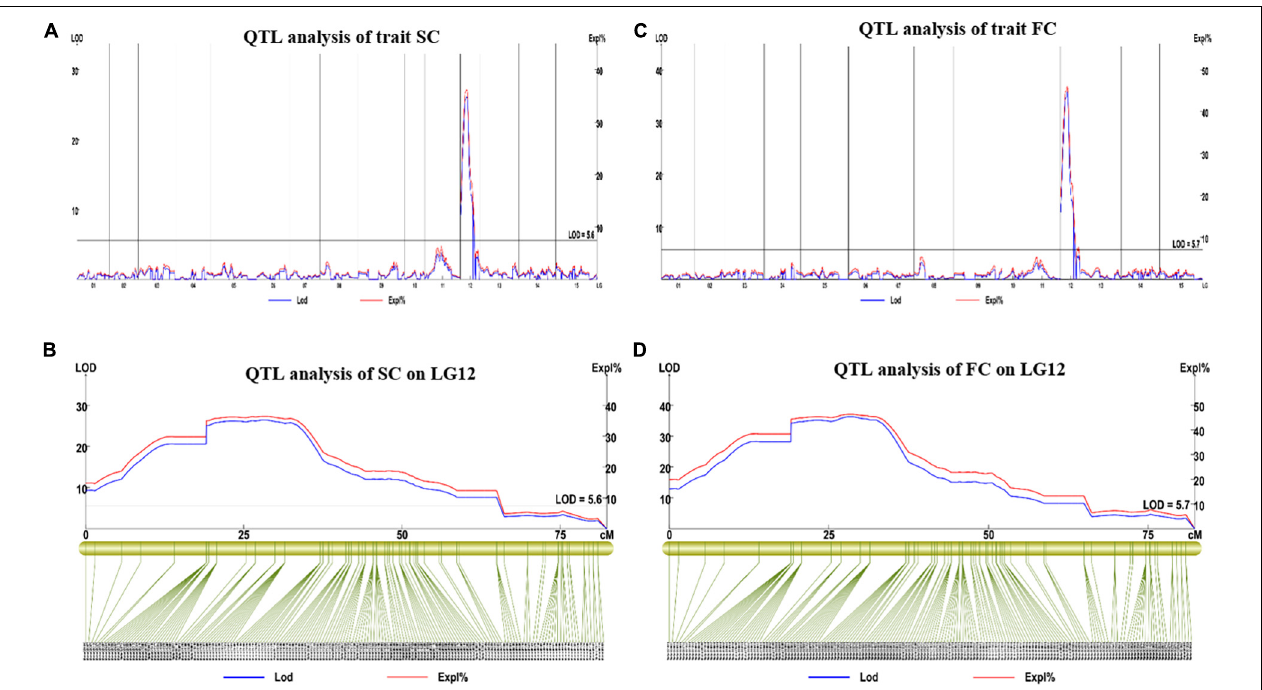
FIGURE 6 | The results of the major QTL test of SC and FC. (A,B) Major QTL test results for the SC on LG12; (C,D) major QTL test results for the FC on LG12. QTL, quantitative trait loci; SC, skin color; FC, Flesh color.